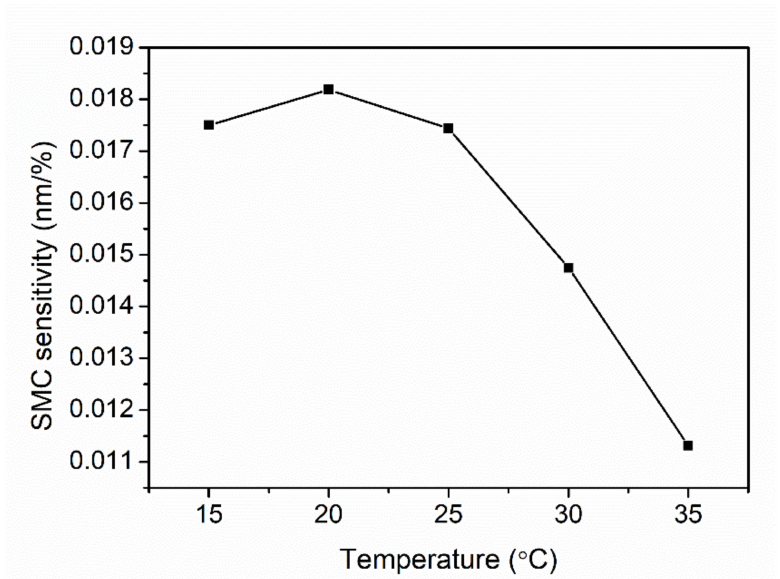
Figure 9. SMC sensitivities calculated in the SMC range between 8% and 24% as a function of temperature change from 15 ◦ C to 35 ◦ C with a step of 5 ◦